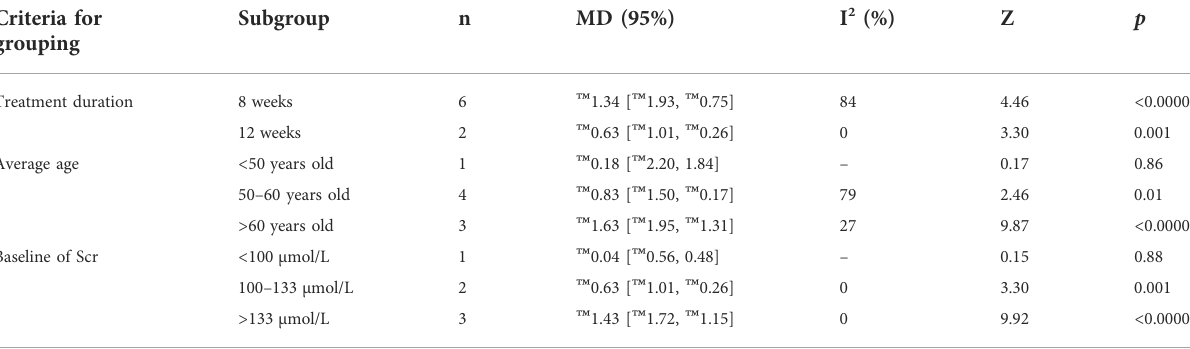
TABLE 4 Subgroup analyses of BUN based on treatment duration, average age, and baseline of Scr. Criteria for